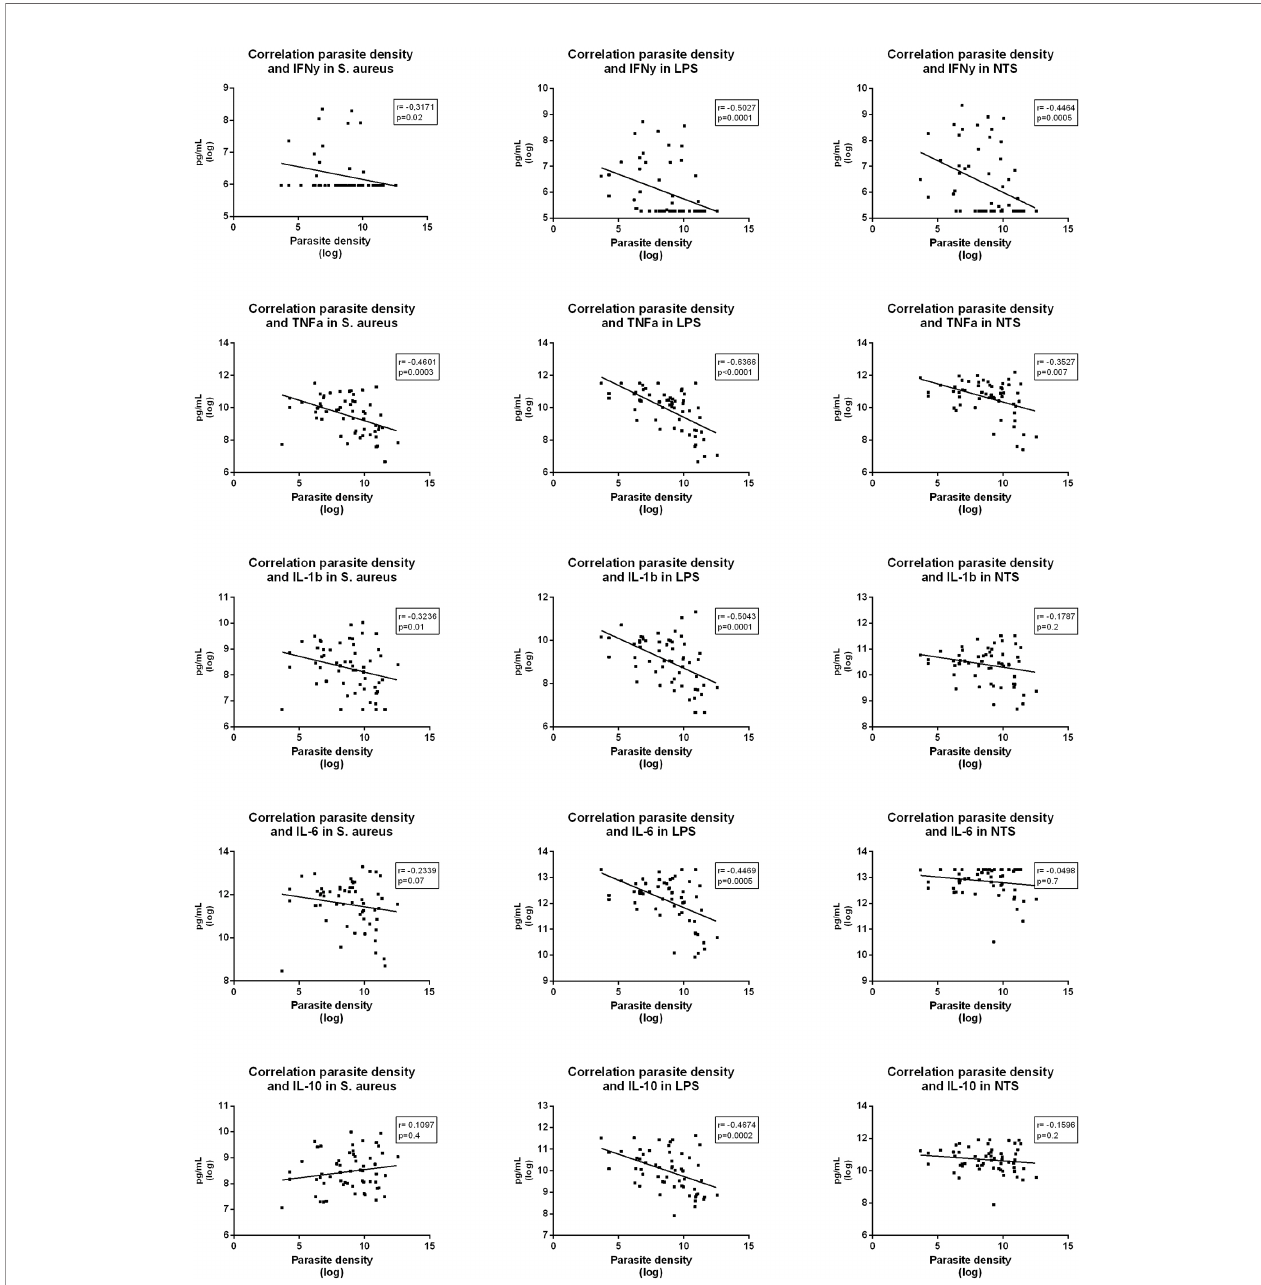
FIGURE 5 | Correlations between parasite density and various cytokine levels measured in supernatants after whole blood stimulation with Staphylococcus aureus, Salmonella Typhimurium (STM) and Escherichia coli LPS (LPS) among participants with asymptomatic